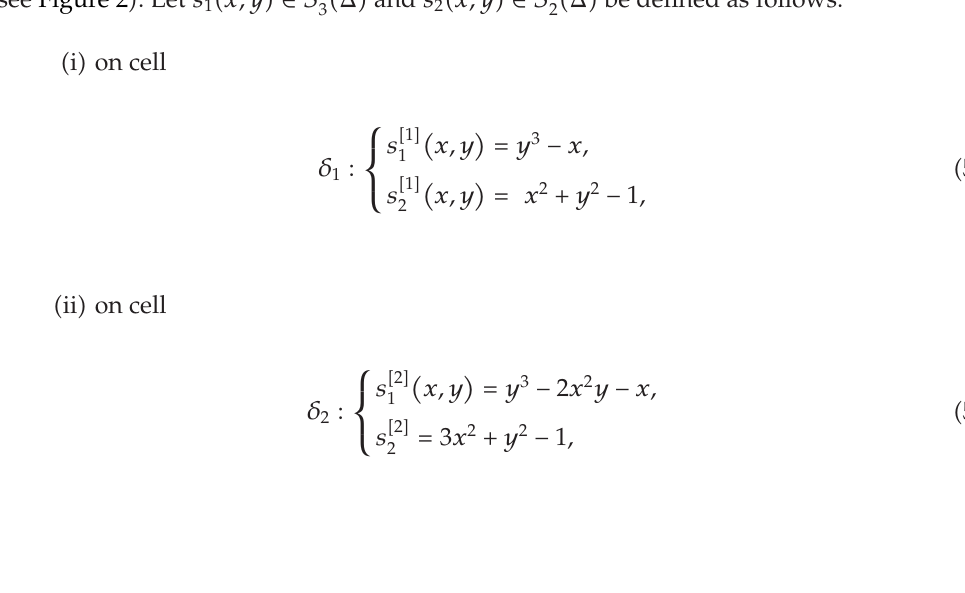
Algorithm 4.1. Isolating the real solutions of piecewise algebraic